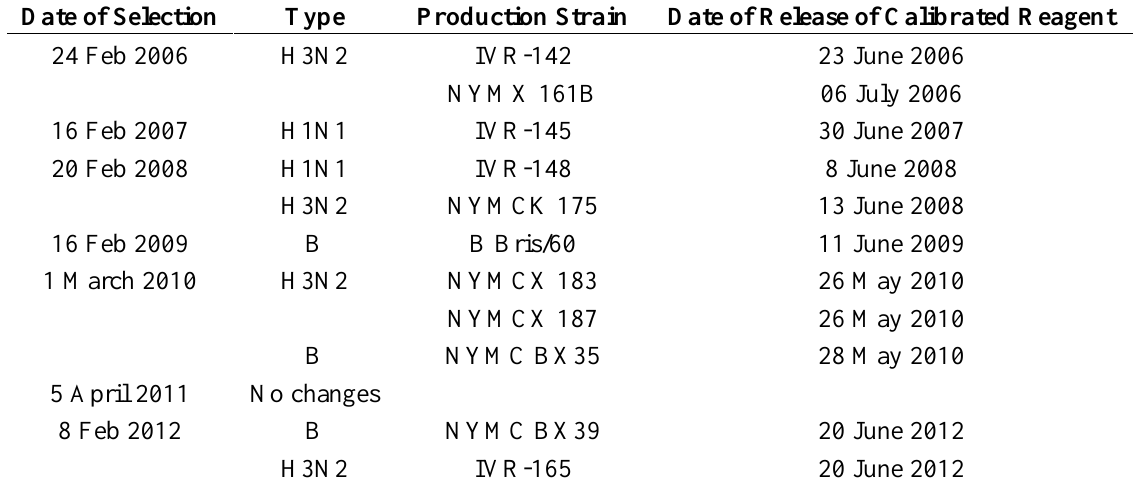
Table 1. Dates of selection of new vaccine strains by WHO and the availability of calibrated